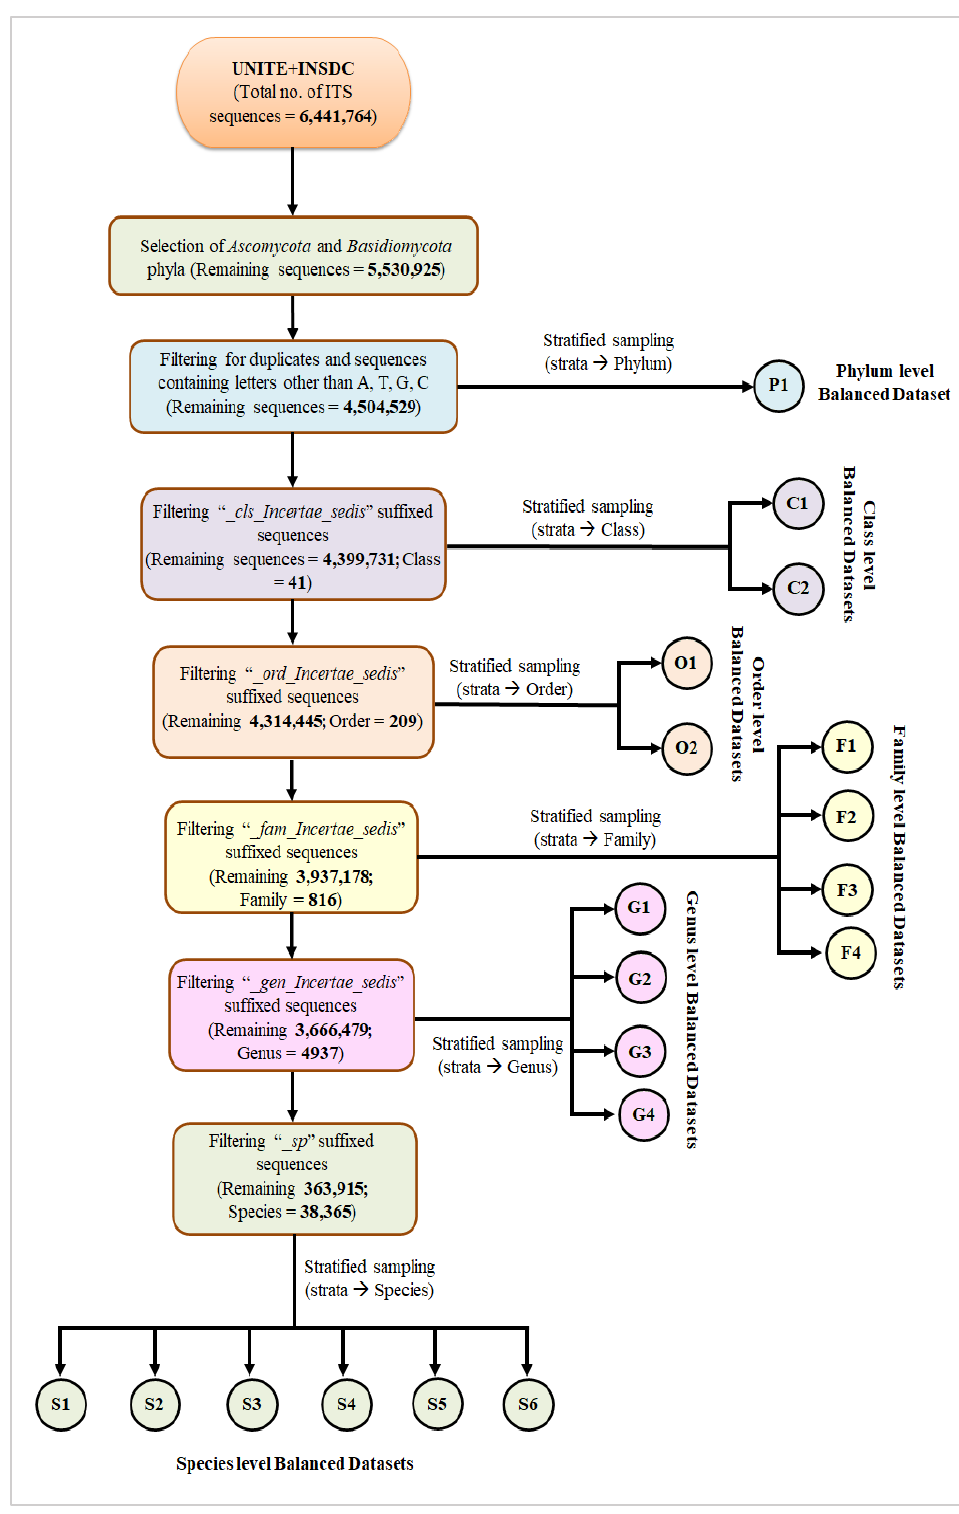
Figure 2. Diagrammatic representation of the pipeline for filtering and construction of balanced ITS sequence datasets at each taxonomic level.